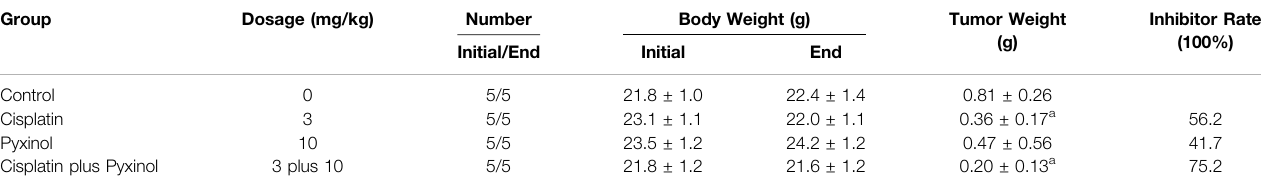
TABLE 1 | Effects of pyxinol on the antitumor activity of cisplatin in nude mice. Group Dosage